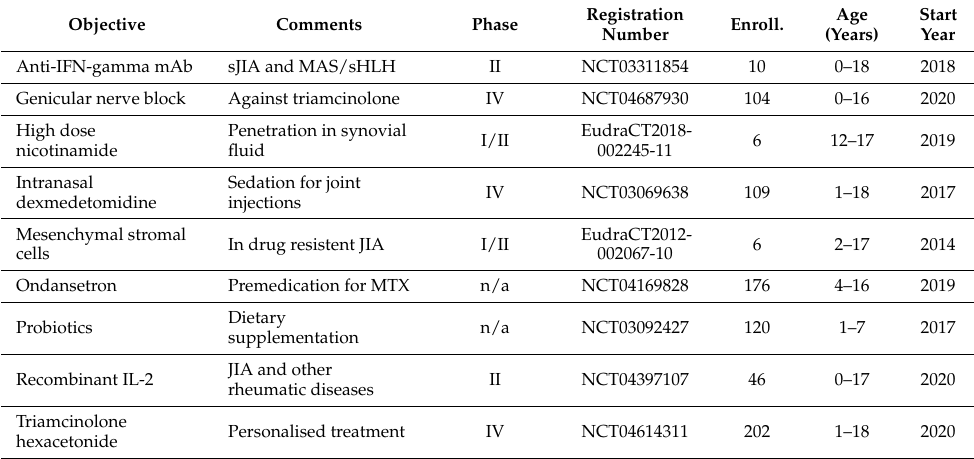
Table 4. Registered studies on medication other than DMARDs.